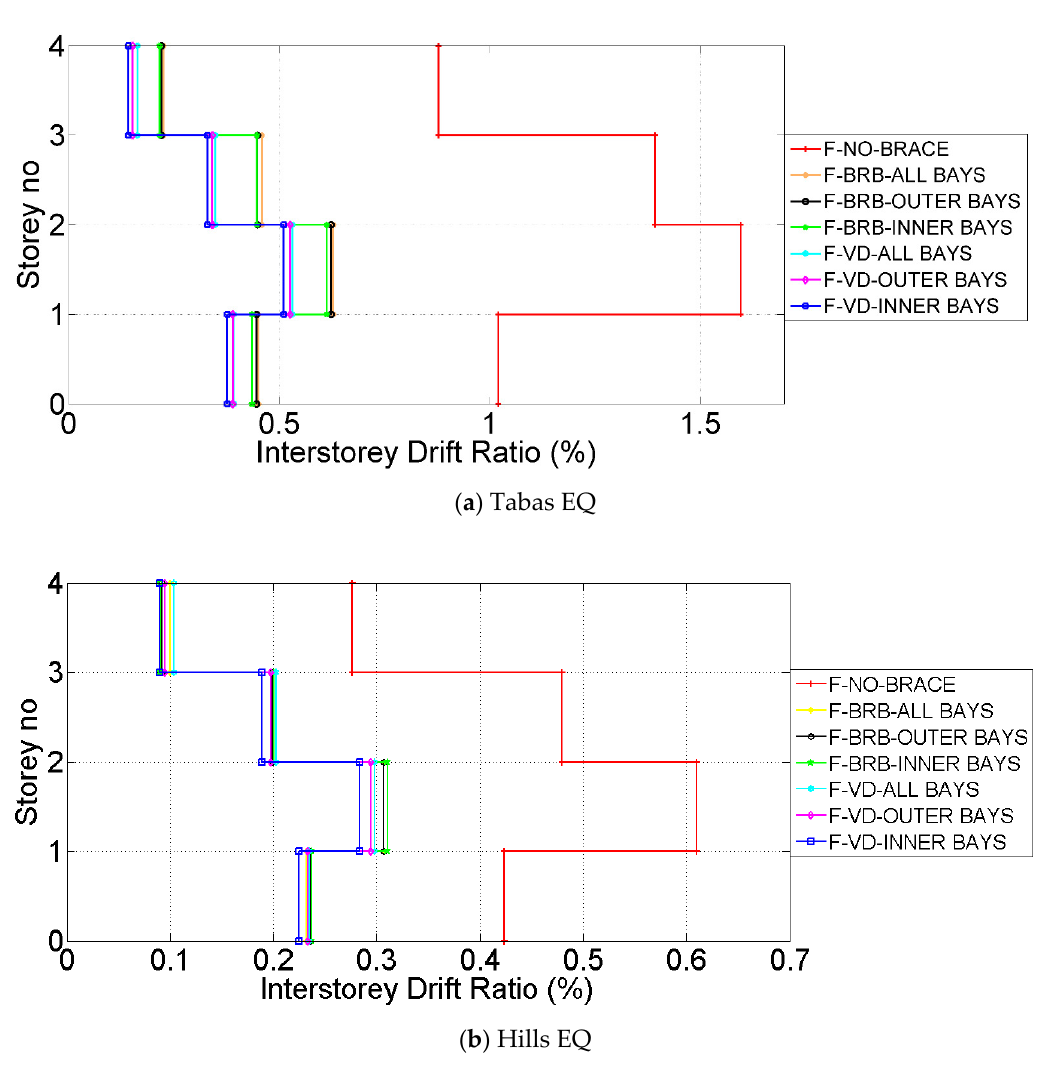
Figure 10. Variation of interstory drift ratio with story level in 4-story frames.